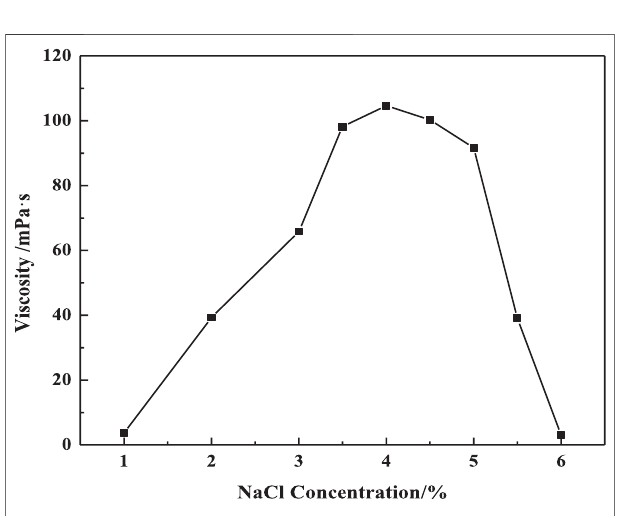
FIGURE 2 | Effect of salinity on apparent viscosity ( w (LBA + SDS) (cid:2) 0.8%, LBA:SDS (cid:2) 3:1, T (cid:2) 50 ° C, γ (cid:2) 7.34s − 1 ).